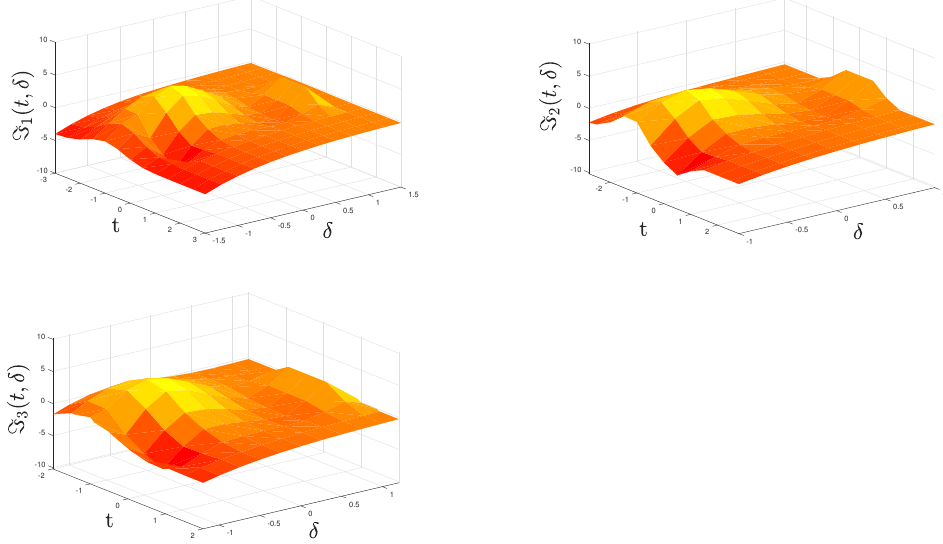
Figure 6. The state trajectories of the corresponding error system of the type (8) in Example 2 with controller (7) for τ =